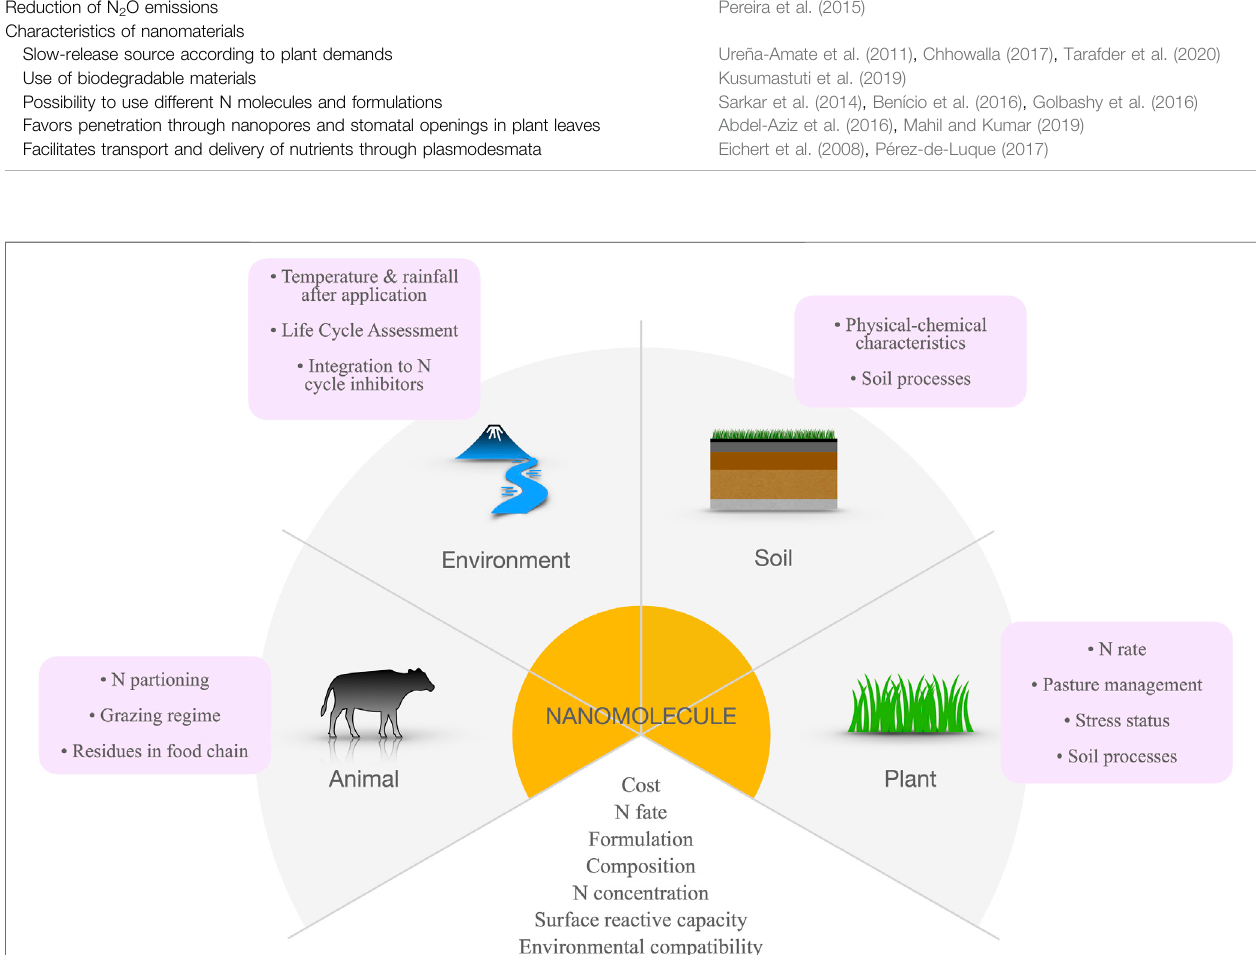
Frontiers in Environmental Science |